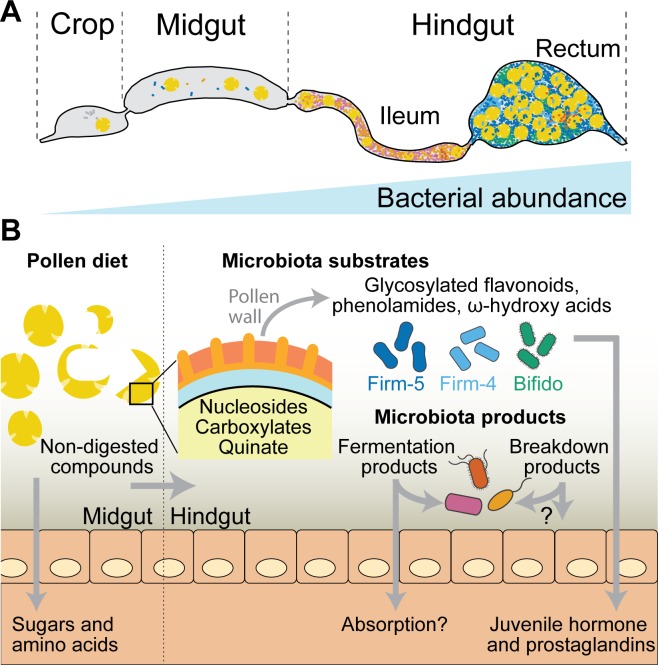
Summary of the metabolic activities of the bee gut microbiota identified in this study.(A) Schematic representation of the bee gut depicting the crop, midgut, and hindgut. The hindgut is divided into the ileum and the rectum, where the highest bacterial densities are found. Bacteria in the ileum are shown in magenta and orange (mostly Proteobacteria), and those in the rectum are shown in green and blue (mostly Lactobacilli and Bifidobacteria). Pollen grains are shown in yellow. (B) Pollen is likely predigested in the midgut, where bacterial levels are relatively low [45]. Here, the host absorbs accessible pollen-derived compounds such as simple sugars (glucose or fructose) and amino acids [46,47]. Nondigested pollen compounds enter the hindgut, where bacterial density is higher. We found nucleosides, various carboxylic acids (e.g., citrate, malate, and fumarate), and aromatic compounds (such as quinate) from pollen to be utilized by bee gut bacteria. In the posterior part of the hindgut (rectum), three community members (Firm-5, Firm-4, and B. asteroides) metabolize major components of the outer pollen wall, including flavonoids, phenolamides, and ω-hydroxy acids. The metabolic activities of the microbiota lead to the accumulation of fermentation products and intermediates of aromatic compound degradation. Some of the bacterial products may be utilized by other community members, as exemplified by the cross-feeding between G. apicola and S. alvi, or absorbed by the host. In addition, the gut symbiont B. asteroides seems to increase the production of several host metabolites (juvenile hormone derivatives and prostaglandins) that have key functions in immunity and physiology.